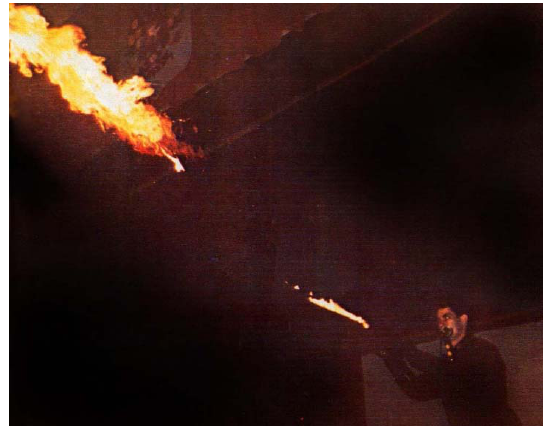
Figure 16. Graeme Revell with a homemade flamethrower designed by Mark Pauline during a Figure 13. Graeme Revell with a homemade flamethrower designed by Mark Pauline during a performance of SPK, 1982, San Francisco. © SPK. performance of SPK, 17 April 1982, Russian Center, San Francisco. ©